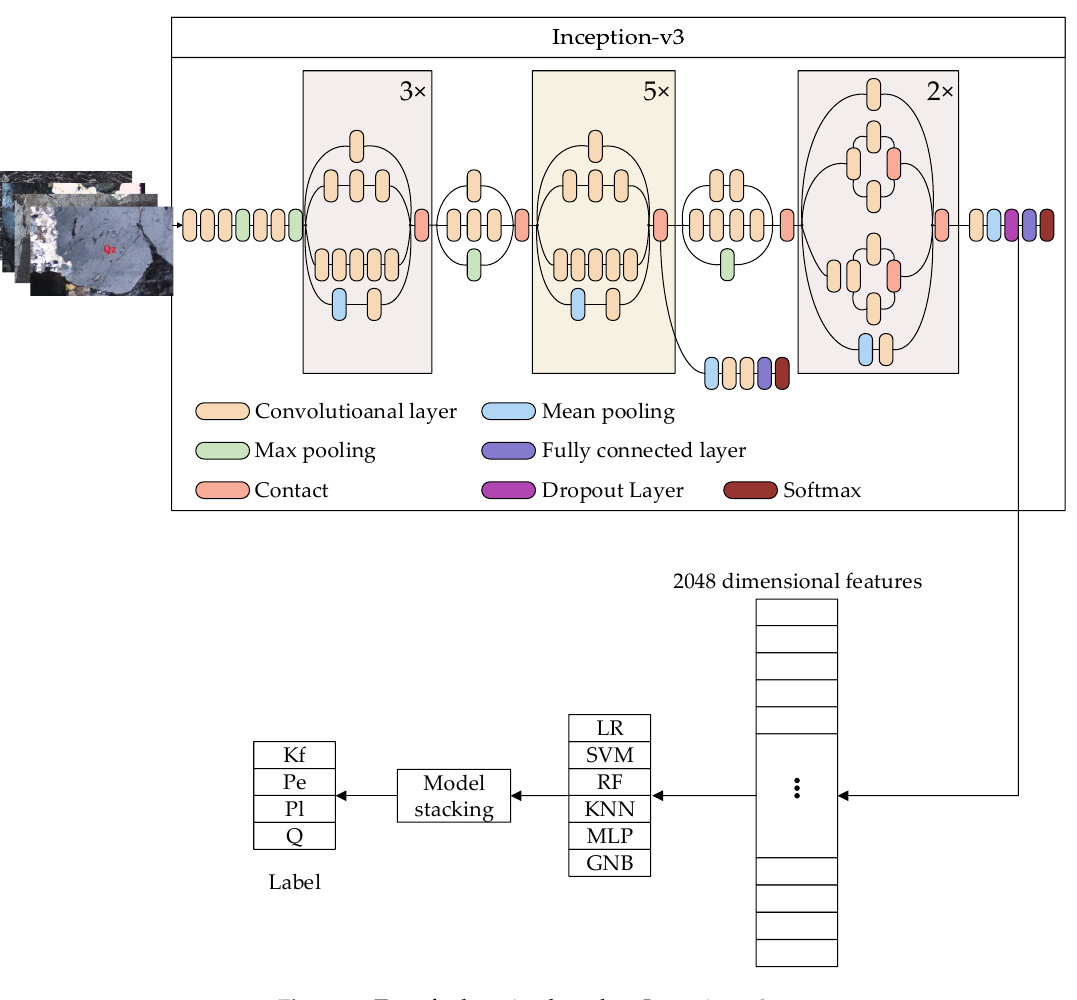
Figure 2. Transfer learning based on Inception-v3.